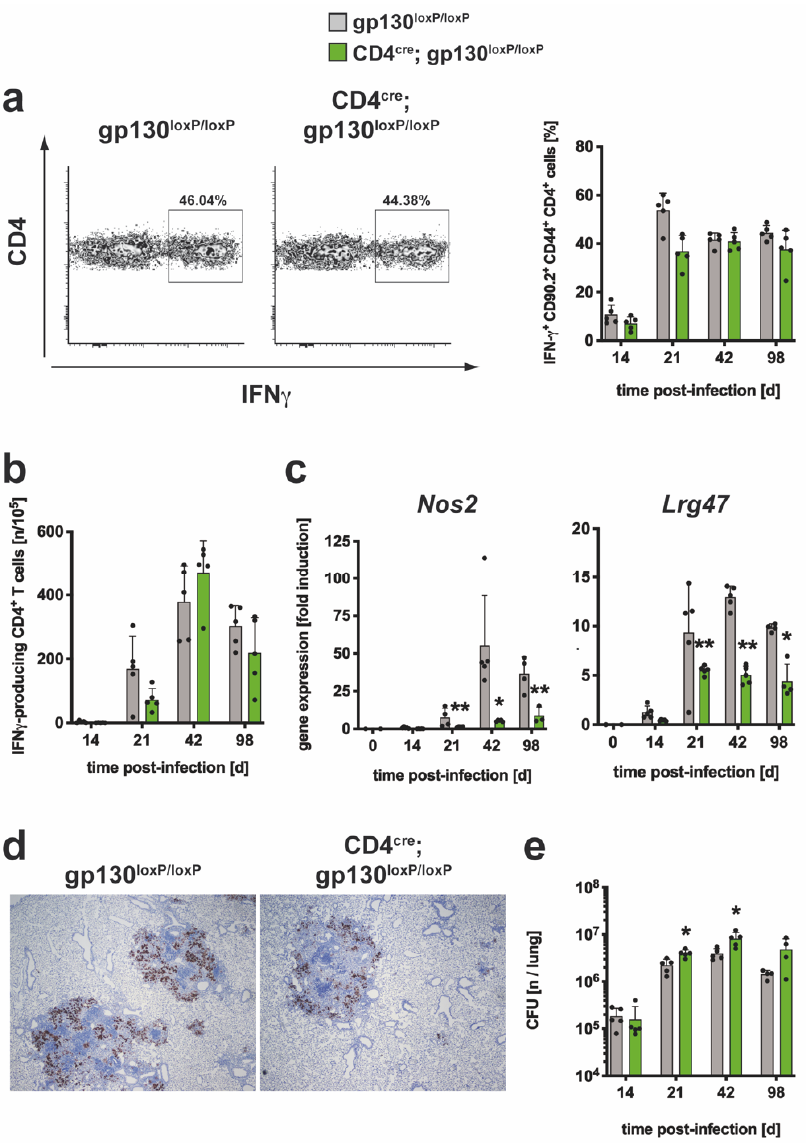
Figure 7. The TH1 immune response in CD4 cre ; gp130 loxP/loxP mice during experimental TB. gp130 loxP/loxP (grey symbols) and CD4 cre ; gp130 loxP/loxP mice (green symbols) were infected with approximately 100 CFU Mtb via the aerosol route. At the indicated time points, lungs were removed and further processed. ( a ) The relative amount of IFN γ -producing CD4 + CD44 + CD90.2 + T cells was determined in single cell suspensions of lungs by flow cytometry after restimulation with anti- CD3/CD28. Representative density plots of IFN γ -producing CD4 + CD44 + CD90.2 + T cells on day 42 and IFN γ -producing CD4 + CD44 + CD90.2 + T cells during the course of infection are shown. ( b ) CD4 + T cells were purified from lung cell suspensions by MACS and restimulated with ESAT-6 1-20 . The frequency of IFN γ -producing cells was determined by ELISPOT. ( c , d ) After reverse transcription of isolated lung RNA, gene expression of ( c ) Nos2 and Lrg47 was quantified by real-time RT-PCR based on gene expression in uninfected mice. ( d ) Representative immunohistochemical staining of NOS2 in lung section of experimental mice 42 days of infection. ( e ) At the indicated time points, bacterial loads in the lungs were determined. Mean values with standard deviations of 5 mice per group are shown. One representative experiment of two is shown. Data were statistically analyzed using the Mann–Whitney test defining differences between cre-negative littermates and CD4 cre ; gp130 loxP/loxP mice as significant (*, p ≤ 0.05; **, p ≤ 0.01).